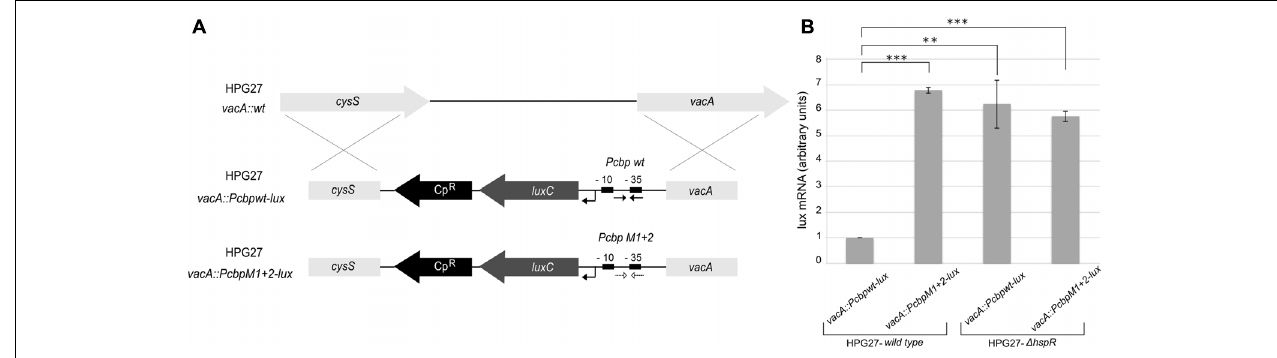
FIGURE 5 | In vivo H. pylori transcripts levels from the P cbp promoter harboring WT or mutant HAIR-like sequences. (A) Schematic representation of P cbpwt - lux and P cbpM1 + 2 - lux reporter constructs obtained transforming the H. pylori G27 wild type acceptor strain by double homologous recombination in the vacA locus, and selected by chloramphenicol resistance (Cp R ). The wild type (P cbpwt - lux ) or HAIR-like mutant (P cbpM1 + 2 - lux ) P cbp promoter is inserted upstream of a luxC reporter gene. The HAIR inverted repeat sequences are indicated by converging black arrows in the P cbp WT promoter (P cbpwt - lux ) and by converging dotted arrows in the P cbp HAIR-like mutant promoter (P cbpM1 + 2 - lux ). In each reporter construct, the –10 and –35 regions are depicted as black boxes and the transcriptional start site as a bent arrow. (B) Transcript levels of P cbp wild type and P cbp HAIR-like mutant promoters fused with lux reporter gene were assayed by qRT-PCR in the wild type and hspR deletion mutant strains using specific oligonucleotides for the luxC gene (LuxRTF/R). Mean values from three independent biological samples are reported in the graph, with error bars indicating standard deviation and asterisks marking statistical significance calculated by a Student’s